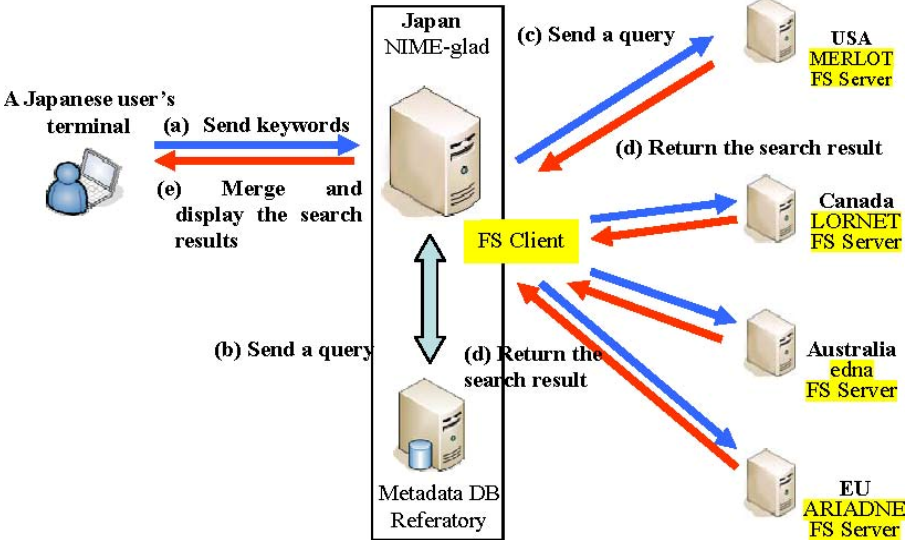
Figure 2. A data flow at GLOBE global federated search (Yoshii, Shimizu & Yamada, 2008) HARVESTING AND ADVANCED ARCHITECTURE FOR THE NEXT-GENERATION GLOBE